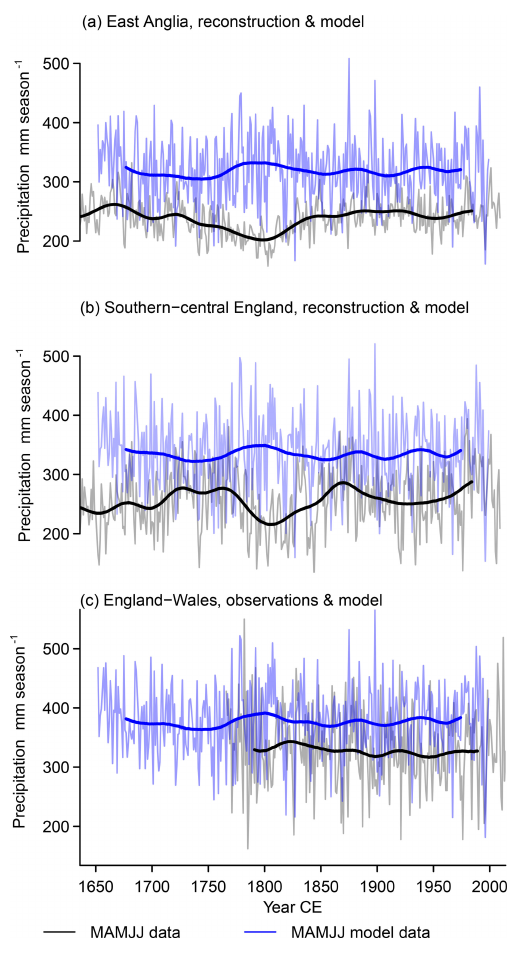
Figure 3. Extended spring (MAMJJ) precipitation in (paleo-)observation-based data and simulation output, (a) East Anglia precipitation in reconstruction (black) and regional model (blue), (b) southern–central England precipitation in reconstruc- tions (black) and regional simulation (blue), and (c) England–Wales precipitation in observational data (black) and regional simulation (blue). We show interannual data (light colors) and 51-point Hamming-filtered data (solid